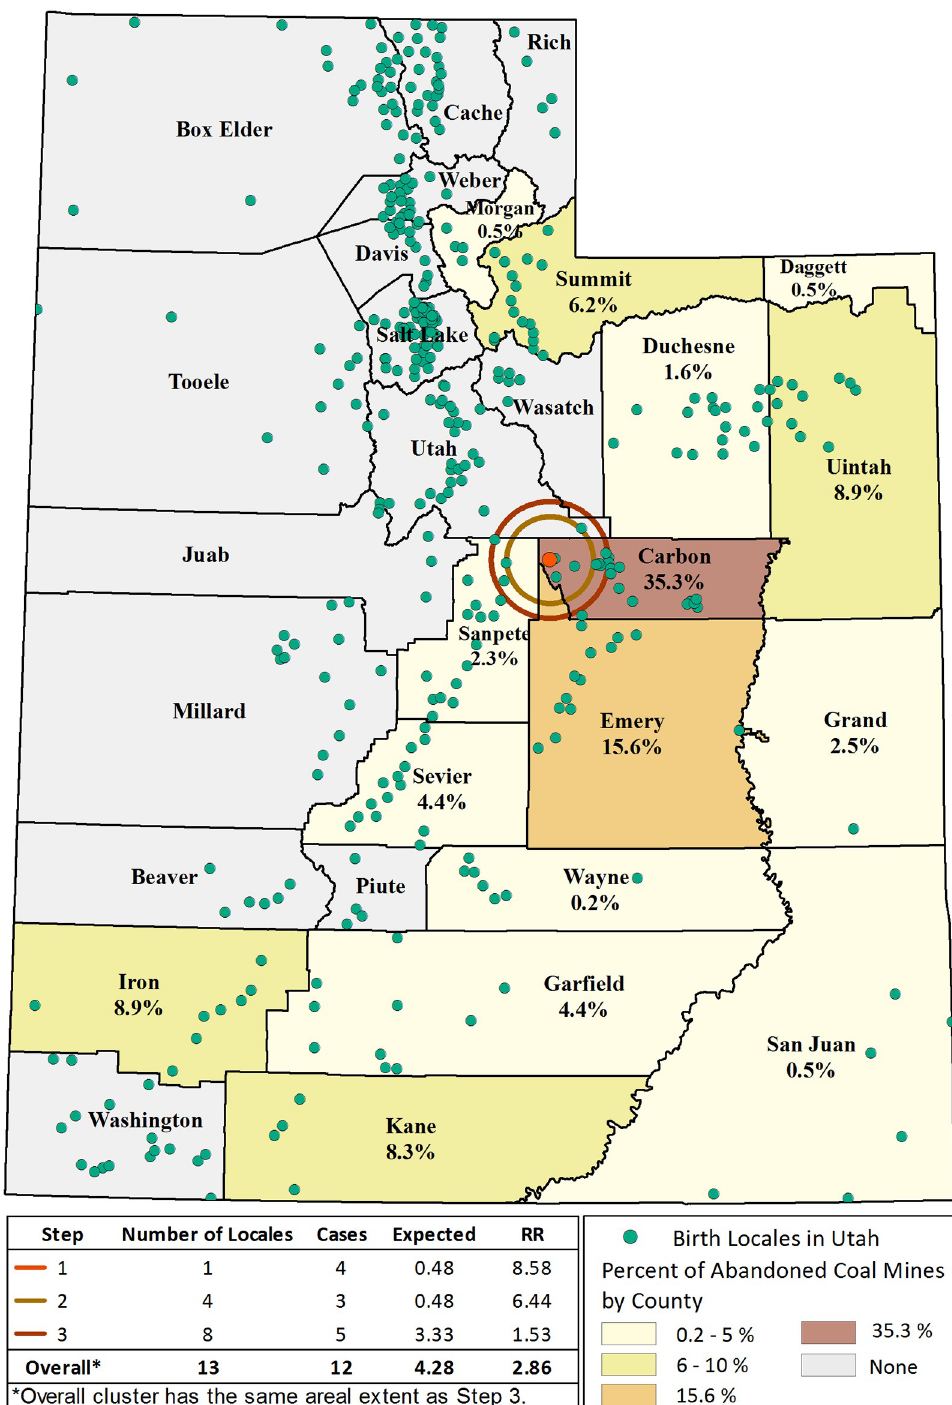
Fig 1. Geographic analysis of SINT cases and controls. The isotonic cluster signal and steps. The overall cluster has a 2.86 relative risk of SINT as shown in dark red. Overlaid on the Utah map are study defined birth locales for Utah (green circles) and the percent of currently abandoned coal mines by